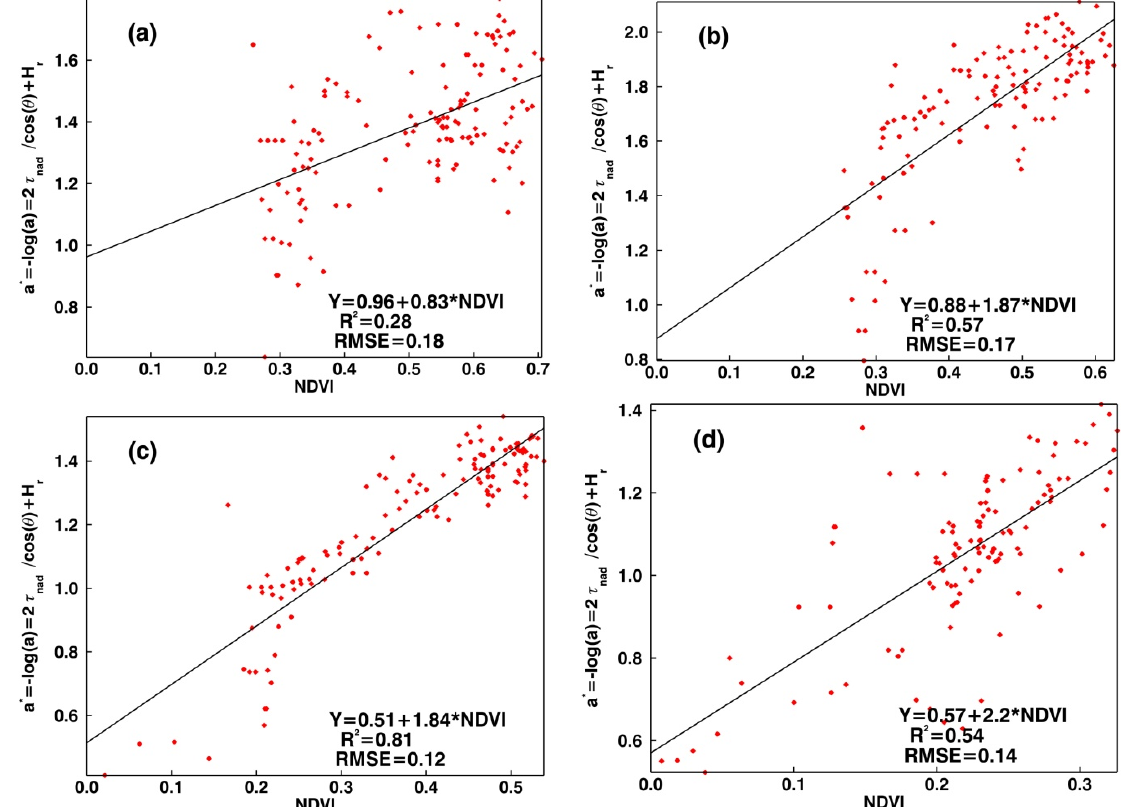
Figure 3. Scatter plot illustrating the relationship between the (cid:1853) ∗ parameter and MODIS NDVI over SCAN sites ( a ) 2092, ( b ) 2093, ( c ) 2018, and ( d ) 2160 (January 2010–September